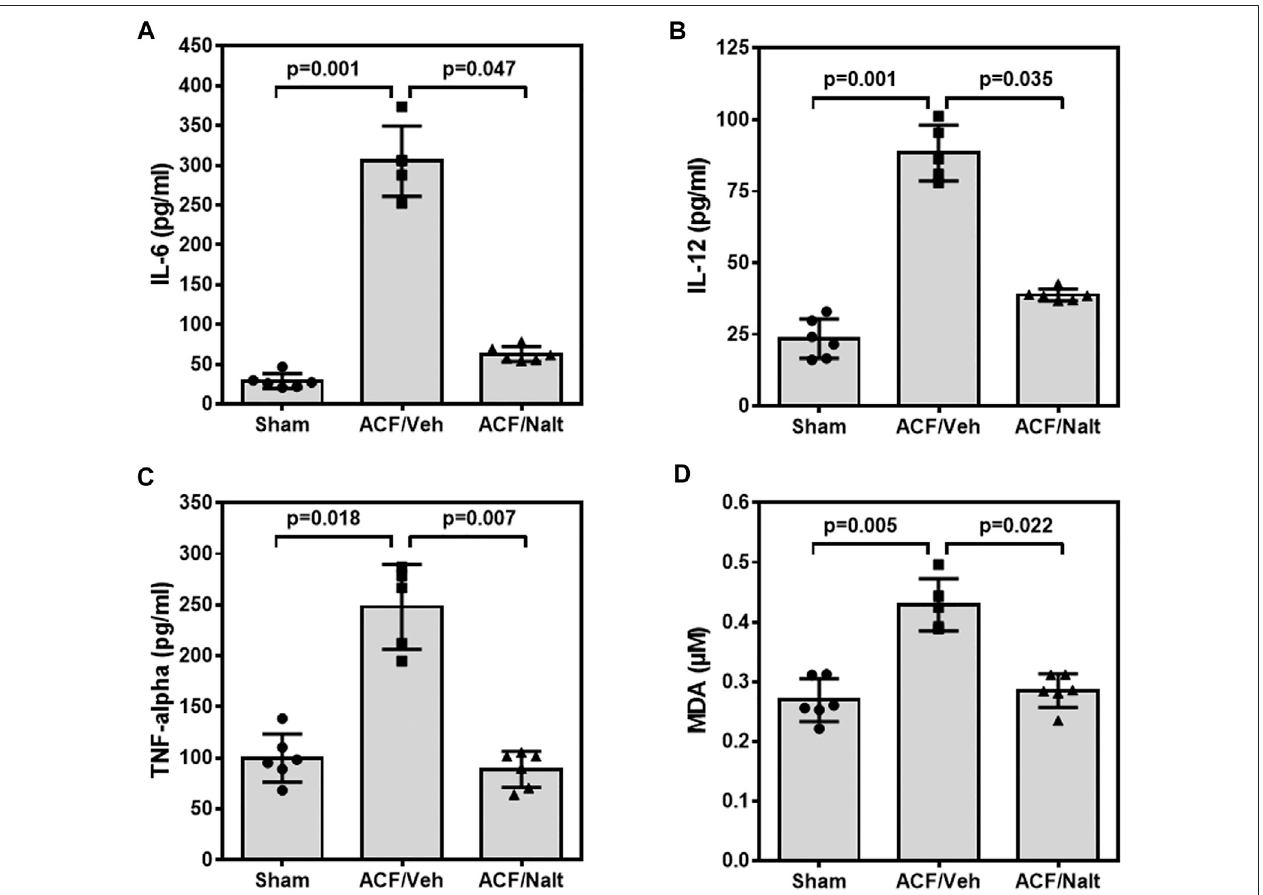
FIGURE5| Interleukin6(IL-6) (A) ,Interleukin12(IL-12) (B) ,tumornecrosisfactor α (TNF- α ) (C) andmalondialdehyde(MDA) (D) valuesofcontrol,ACF/Vehicle-and ACF/Naltrexone-treatedrats.Valuesofin fl ammatorycytokinesandmalondialdehydeweresigni fi cantlyincreasedinACF/Vehicletreatedratscomparedtocontrols(IL-6: p = 0.001; IL-12: p = 0.001; TNF-alpha: p = 0.018; MDA: p = 0.005). Chronic naltrexone treatment in ACF rats was concomitant with a signi fi cant decrease in the in fl ammatory cytokines and lipid-peroxidation (IL-6: p = 0.047; IL-12: p = 0.035; TNF-alpha: p = 0.007; MDA: p = 0.022). Values are medians plus interquartile ranges ( n = 6 rats/group). Data represent medians